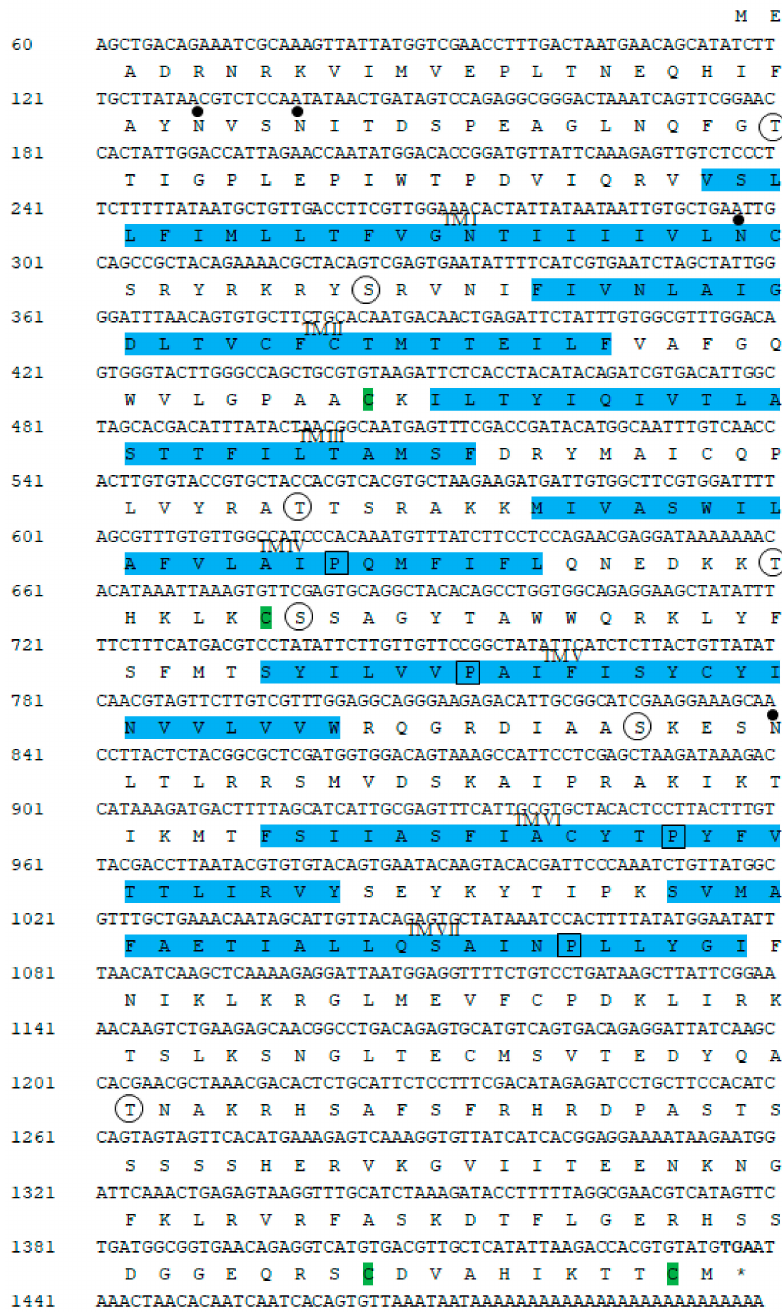
Figure 1. Full-length nucleotide and deduced amino acid sequences of the cloned GnRH-R gene from H. discus hannai . Initiation and termination codons (asterisks) are in bold font. The seven putative transmembrane domains are highlighted with light blue and indicated by roman numerals. Possible N-linked glycosylation motifs are designated by dots. Potential sites for phosphorylation are indicated by circles. Four cysteine residues (Cys-130, Cys-207, Cys-450, and Cys-459) that are likely to form intramolecular disulfide bridges are shaded in green. The proline residues that have been shown to be involved in the GnRH-R binding pocket are denoted by black